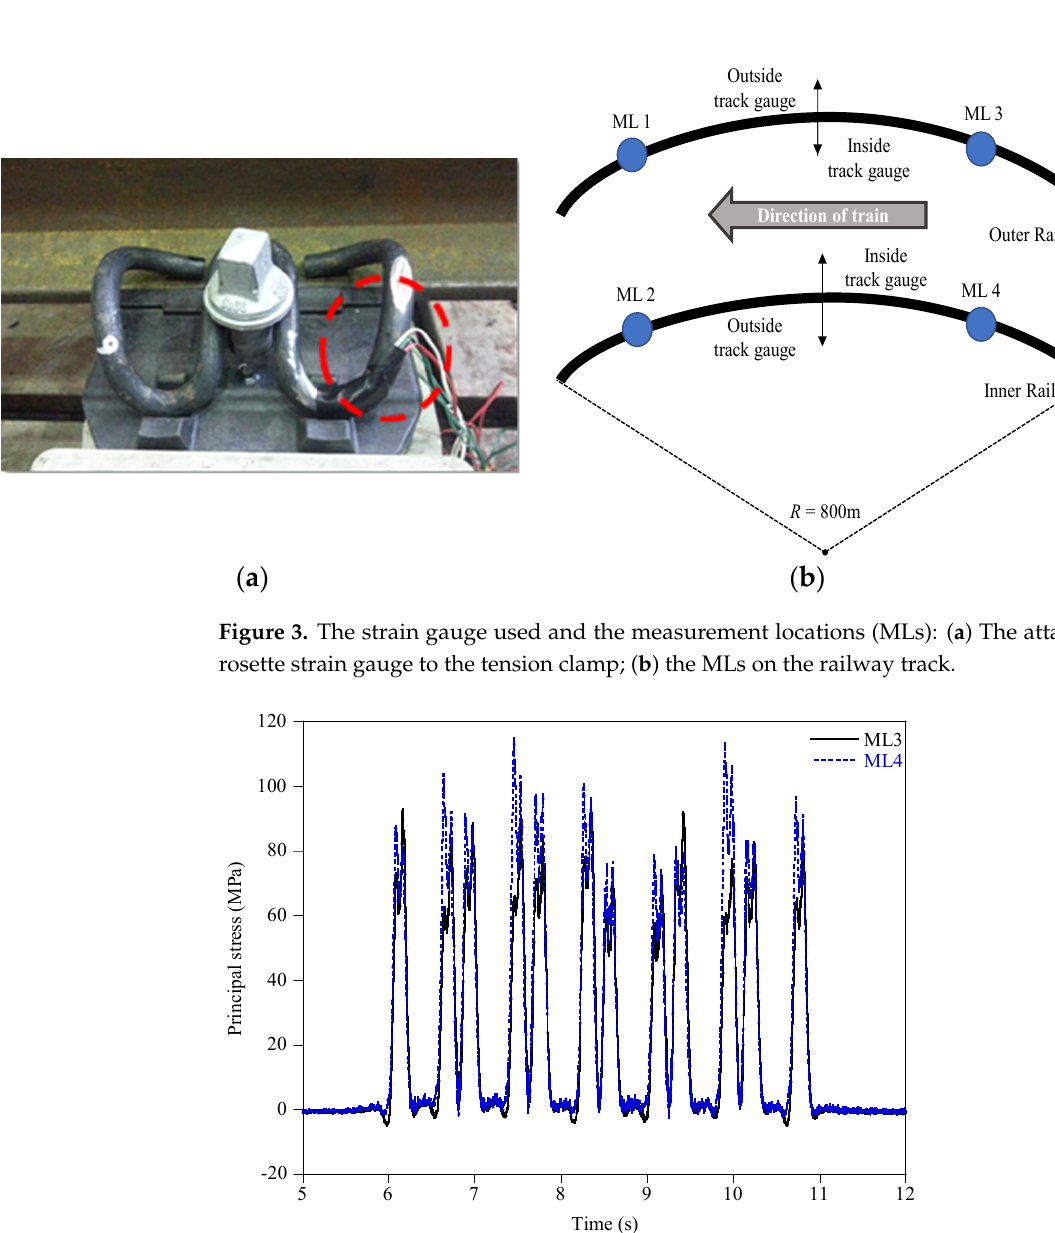
Figure 4. The variations in the principal stresses for the outside track gauge at ML3 and ML4. The rainflow-counting algorithm [18] was adopted to calculate the stress range and the histograms of the stress ranges of the main vibrations are plotted for the four MLs in Figure 5. The histogram for the stress range of the inside track gauge at ML3 is not presented because there was a measurement error in the data. The stress ranges due to the main vibrations were calculated as 55 to 120 MPa, while the stress range due to the residual vibrations was 30 MPa or less. According to the findings from a previous study [19], a stress range of less than a quarter of the constant amplitude fatigue threshold (CAFT) can become truncated. Since the CAFT of the base metal is 165 MPa [20], the stress ranges that were less than 41 MPa could be